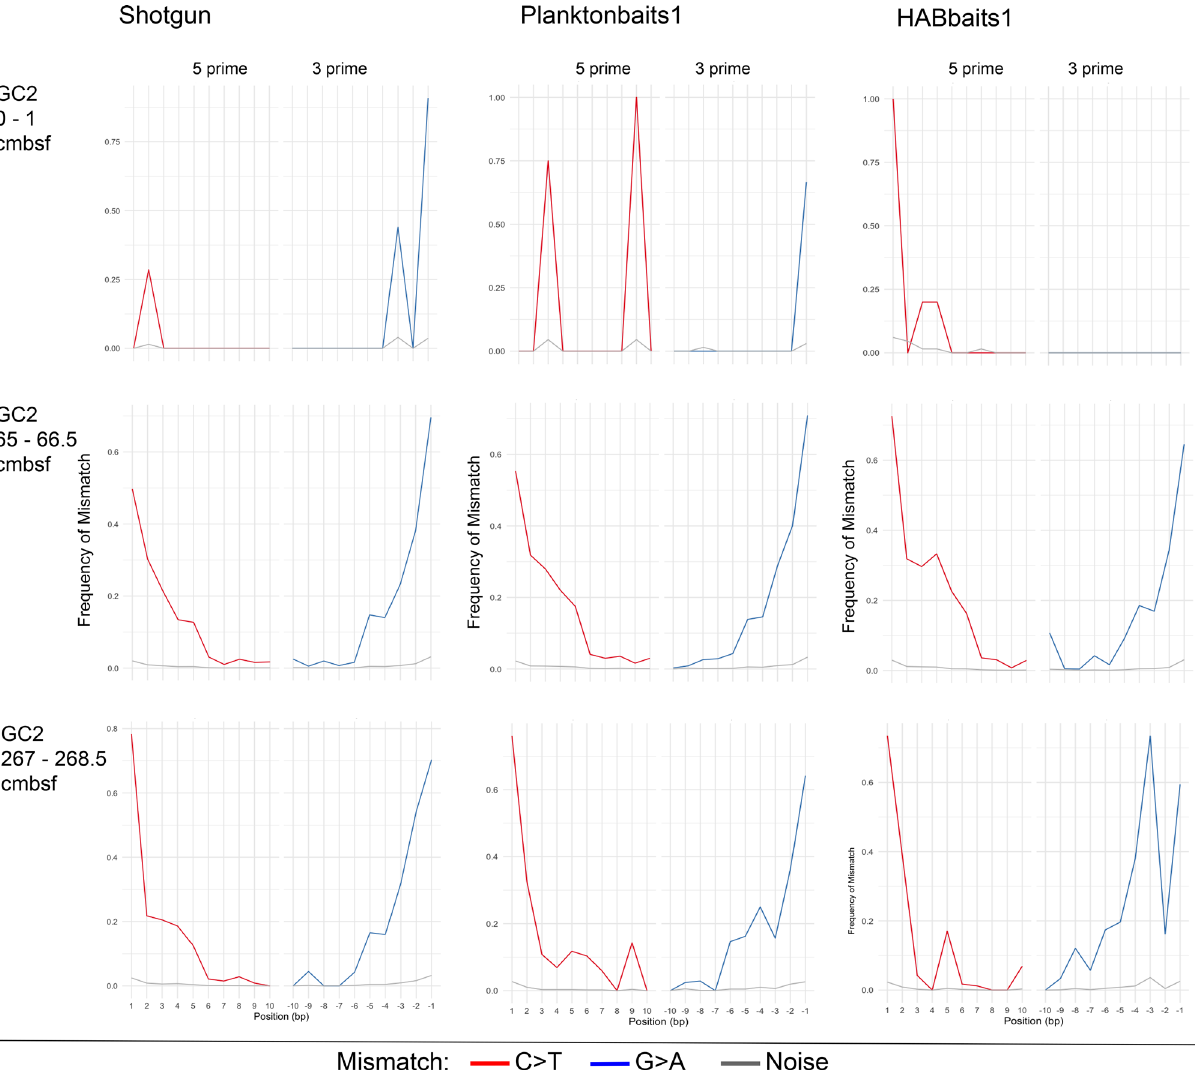
Figure 6. Sed aDNA damage profiles of Emiliania huxleyi in GC2 . E. huxleyi sed aDNA damage profiles (frequency of mismatch against base pair position) per sample for Shotgun, Planktonbaits1 and HABbaits1 in GC2. The red and blue lines denote C > T substitutions in 5 ′ direction and G > A substitutions in 3 ′ direction, respectively, for all ancient alignments. Grey lines denote estimated noise 23 . Shown are selected samples only (top, mid-depth and bottom sample), for damage profiles of all samples see Supplementary Material Fig.